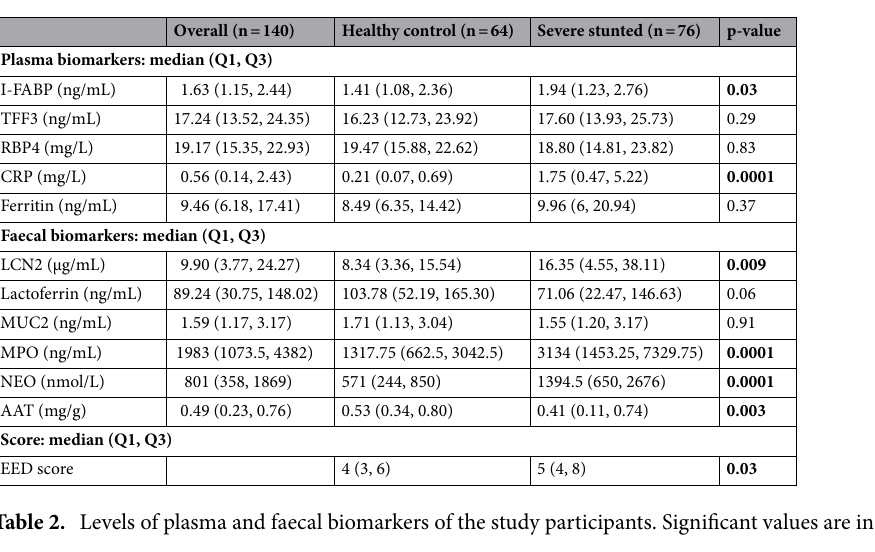
Table 2. Levels of plasma and faecal biomarkers of the study participants. Significant values are in bold.